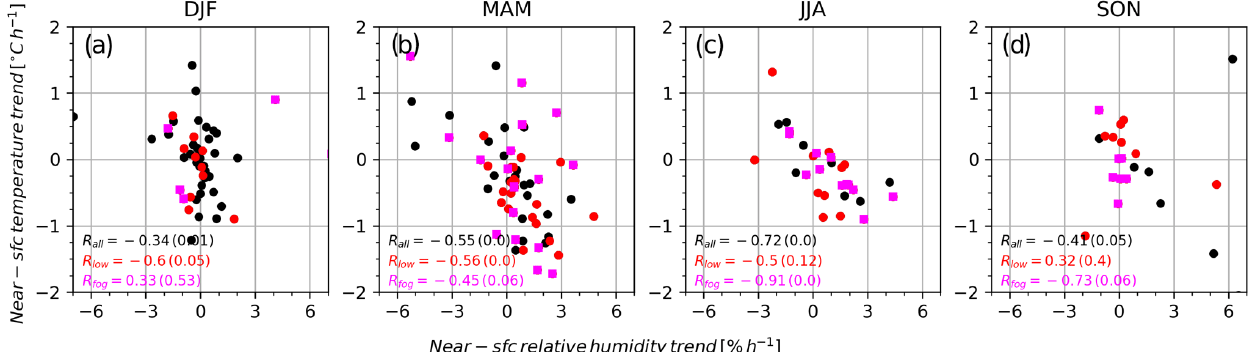
Figure 9. Seasonal linear trends in near-surface air temperature [ ◦ Ch − 1 ] vs. linear trend in relative humidity [%h − 1 ] computed using linear regression of temperatures and relative humidity in a 2h period prior to elevated (black circles), low cloud (red circles) and fog (magenta squares) formation. Relative humidity was computed with respect to ice for November through May and with respect to liquid for June through October, based on monthly mean near-surface temperatures. Seasonal Pearson correlation coefficients and p values are included for each subset of cloud formation